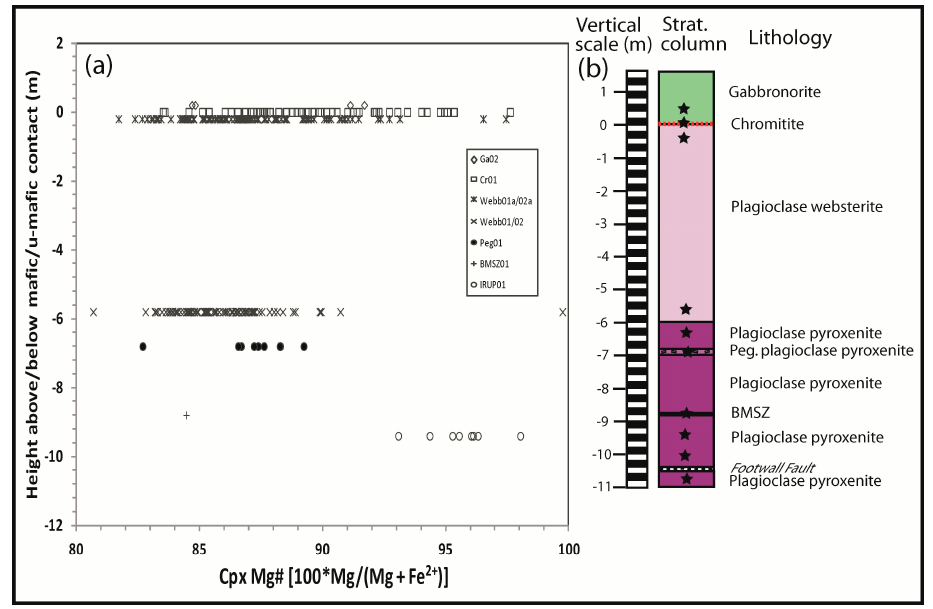
Figure 13. ( a ) Plot of clinopyroxene Mg#s versus stratigraphic height of the MSZ for all clinopyroxene analyses. Corresponding sample locations and lithologies are shown in ( b ).